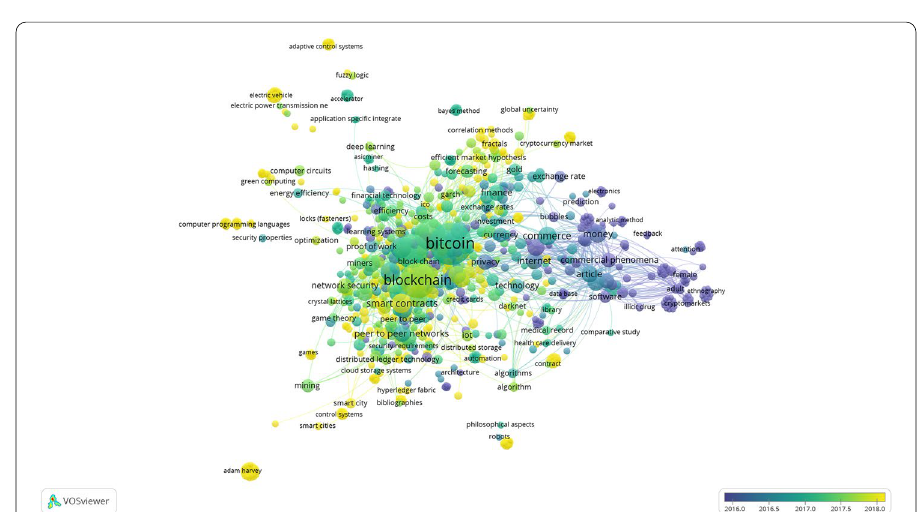
Fig. 11 Keywords on Scopus. Source : Own